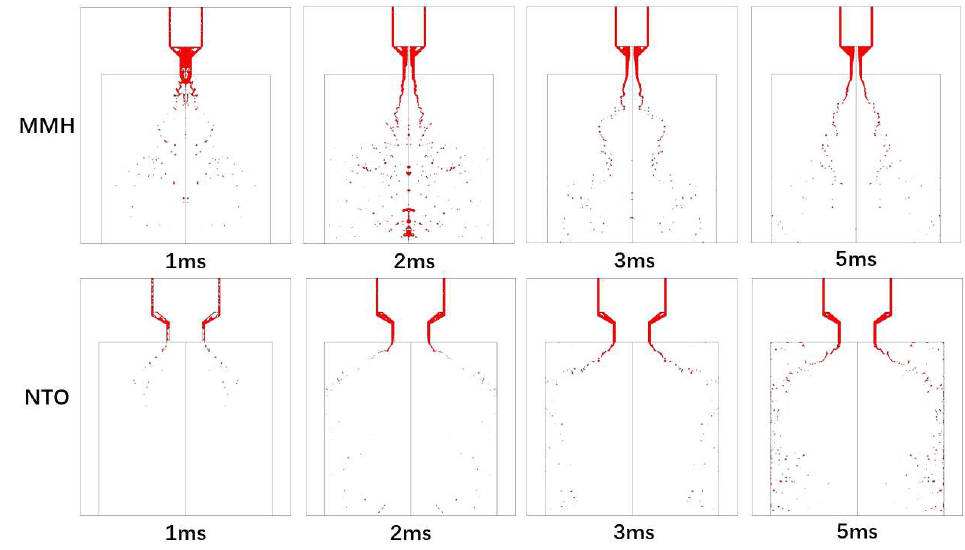
Figure 6. The development of MMH and NTO transient spray atomization over time after valve opening.